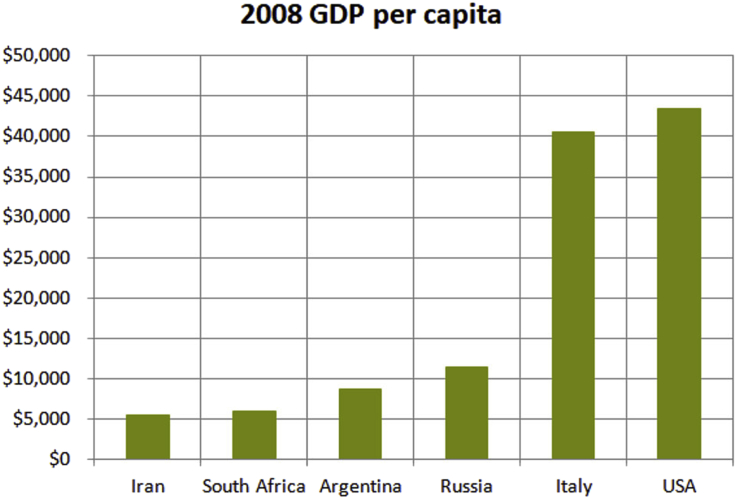
Prior year per capita GDP of countries in Buchan et al., (2009).